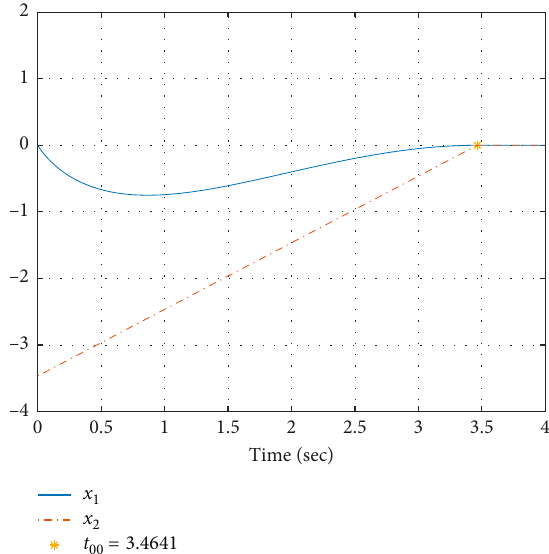
Figure 6: Finite-time convergence ( A � − ( 1/4 ) ).